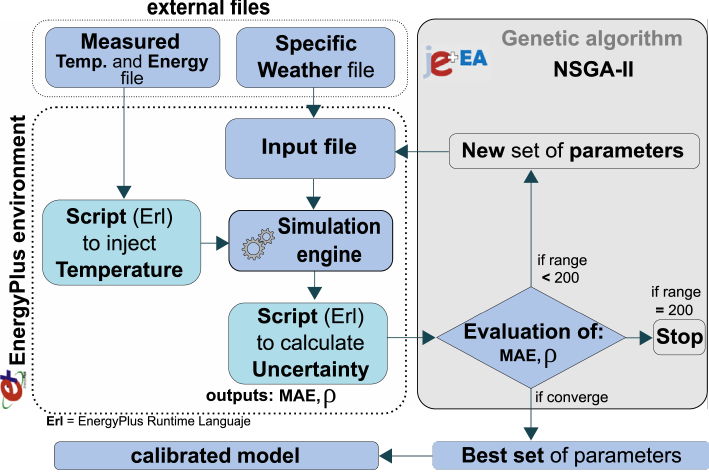
Figure 3. Calibration environment with genetic